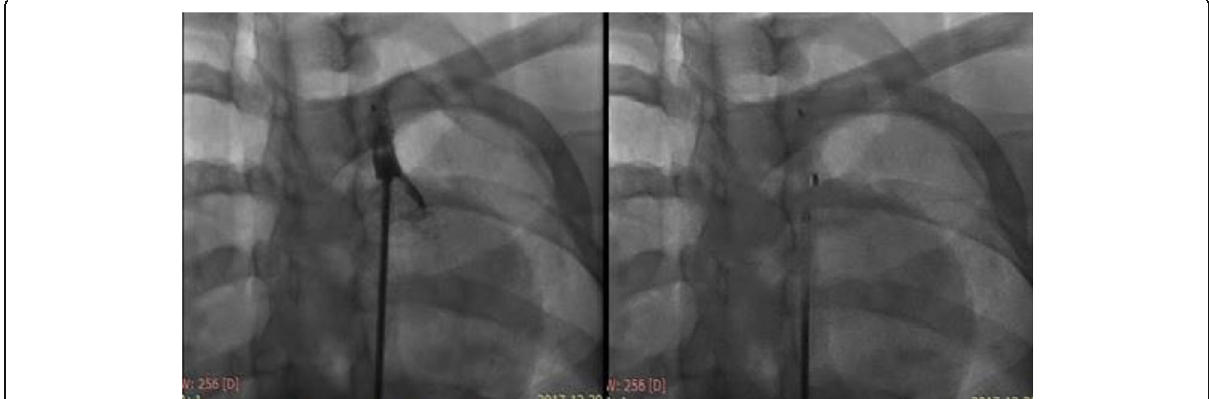
Fig. 4 Obstruction of the subclavian artery with PDA